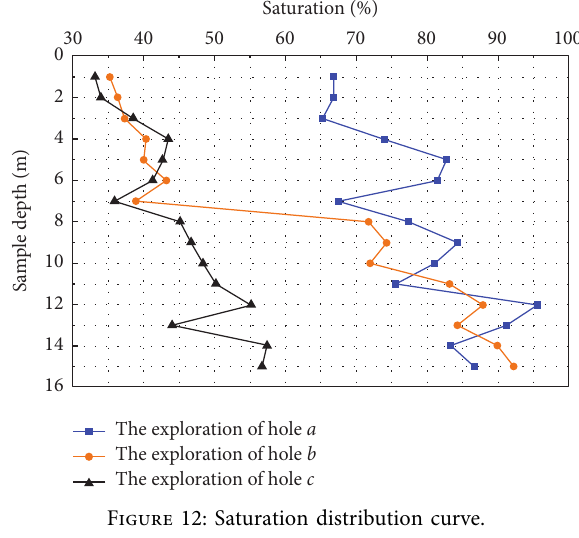
Figure 12: Saturation distribution curve.